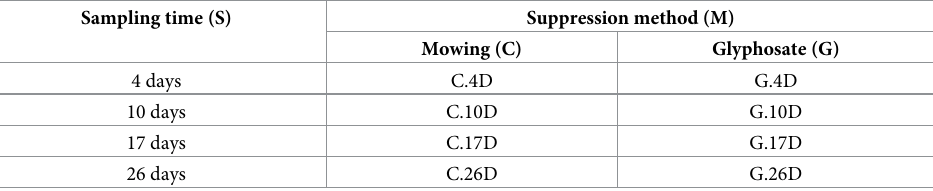
Table 1. Design of treatments in the experiment. A factorial design was considered with two factors under study: suppression method (M) and sampling time (S). The labels of the eight treatment-combinations, with four replicates each (n = 4), are